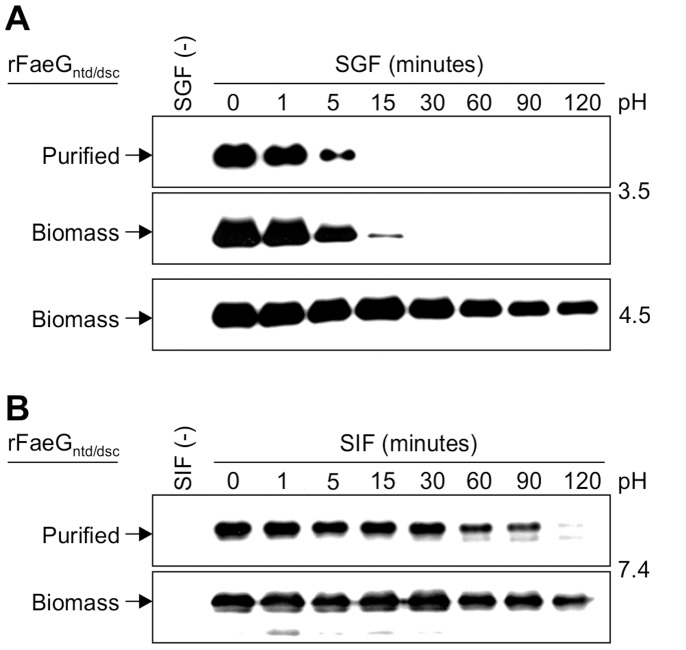
Stability of rFaeGntd/dsc under simulated gastrointestinal conditions.Time course analysis of the stability of chloroplast-expressed rFaeGntd/dsc in simulated gastric fluid (SGF; a) and simulated intestinal fluid (SIF; b). rFaeGntd/dsc was present in similar amounts either as purified protein (“Purified”) or as lyophilized and powdered transplastomic leaf tissue (“Biomass”) and was visualized by western blotting. SGF digestion of leaf biomass was done at two different pH values: pH = 3.5 and pH = 4.5. SGF and SIF fluids with no substrate [SGF (−) and SIF (−), respectively] represent negative controls. The rFaeGntd/dsc band is indicated with an arrow.